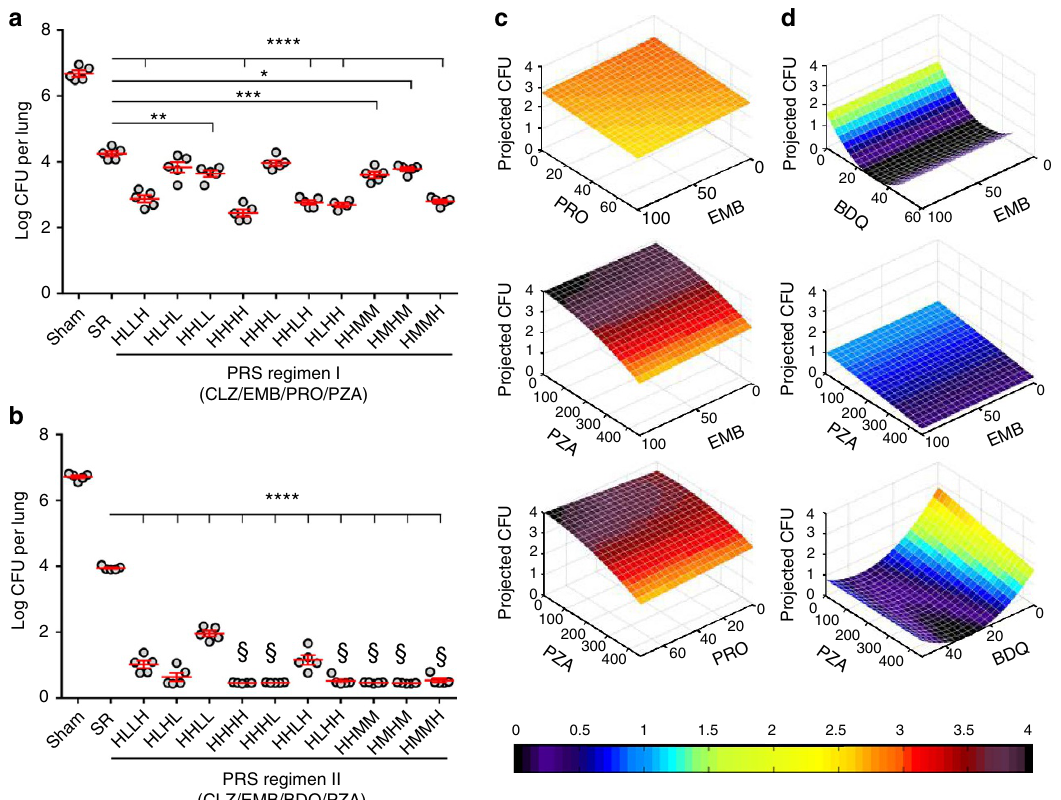
Figure 1 | Short-term efficacy studies of PRS Regimens I and II. ( a , b ) Lung burden of M. tuberculosis in mice that were sham-treated, treated with the Standard Regimen (SR) or treated with PRS Regimens I ( a ) or II ( b ) with the drugs administered at high (H), middle (M) or low (L) dose five times per week for 4 weeks. Data are mean ± s.e.m. of log 10 CFU for n ¼ 5 mice per group. All treatment groups had significantly fewer CFU than the sham-treated group ( P o 0.0001). Differences in treatment efficacy between the Standard Regimen and individual PRS Regimen I or II groups were evaluated by one-way ANOVA with Tukey’s correction. * P o 0.05, ** P o 0.01, *** P o 0.001, **** P o 0.0001. y No M. tuberculosis CFU detected—data plotted as discussed in Methods. ( c , d ) Heat maps of the drug-dose response surface for PRS Regimens I ( c ) and II ( d ). These 3-dimensional graphs show how the projected number of lung CFU changes as the dose of one and/or the other drug is increased or decreased. Drug dose is shown in mgkg (cid:2) 1 . In these plots, in addition to CLZ, the third drug is kept at the high